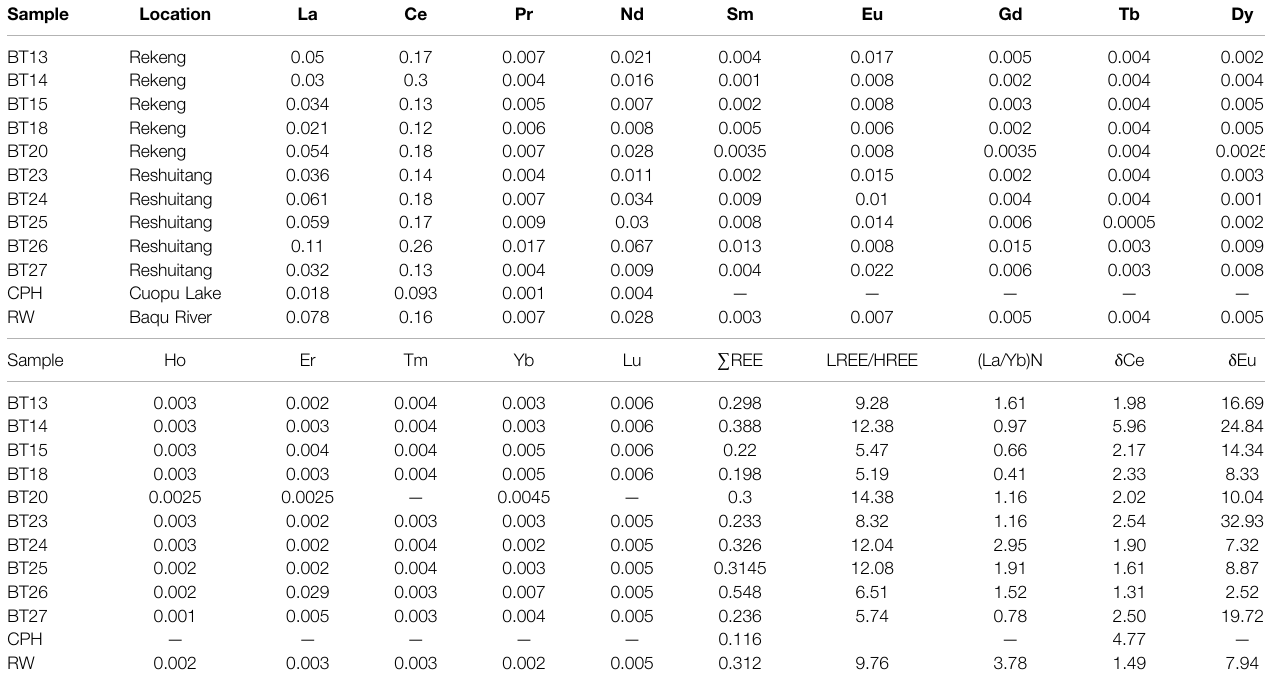
TABLE 2 | Rare Earth element composition of geothermal water in the study area (ug/L).